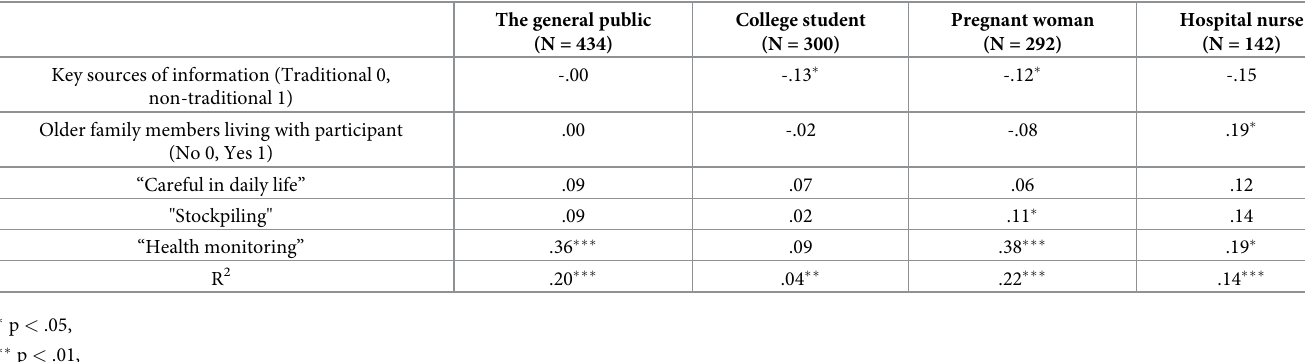
Table 3. Related factors of fear of infection for each